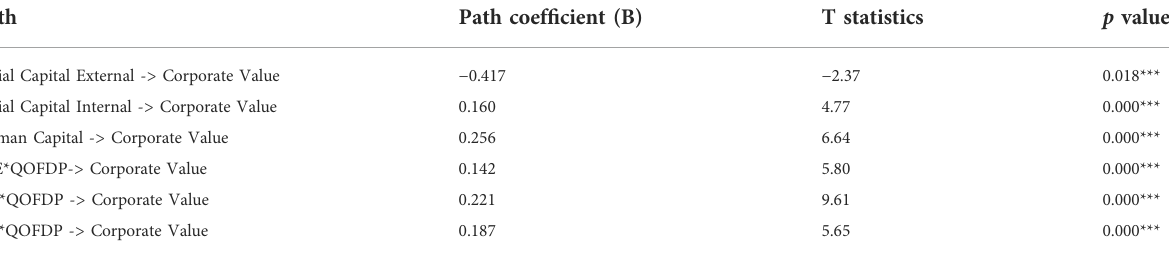
TABLE 8 Hypothesis summary.